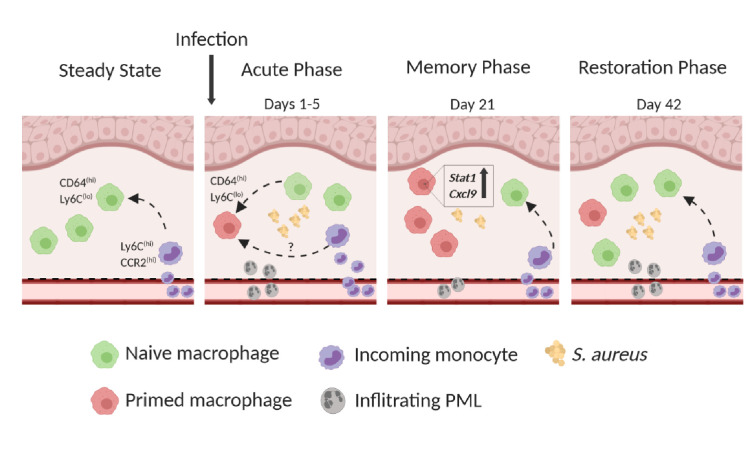
Model of innate immune memory during S. aureus skin infection.Steady State: CD64hi, Ly6Clo Mφ have a half-life of 5–6 weeks and are replaced by CCR2hi, Ly6Chi incoming monocytes. Within the tissue, monocytes downregulate CCR2 and Ly6C and upregulate CD64. Acute Phase: Resident CD64hi Mφ respond to primary S. aureus infection and adopt a memory phenotype, thus becoming primed for subsequent infection. However, infection results in reduced Mφ half-life and increased influx of CCR2hi, Ly6Chi monocytes which may also undergo priming within the microenvironment. The acute phase is further characterized by high numbers of PMLs infiltrating the tissue. Memory Phase: S. aureus is cleared faster during secondary infection due to primed Mφ which are characterized by increased expression of Stat1 and Cxcl9. Reduced numbers of skin infiltrating PMLs are present in the tissue compared to naïve mice. Restoration Phase: Innate immune memory is lost due to continual influx of Ly6Chi monocytes which give rise to naïve Mφ and replace primed Mφ. Naïve Mφ lack increased expression of Stat1 and Cxcl9 resulting in slower bacterial clearance and increased skin PMLs after secondary infection.